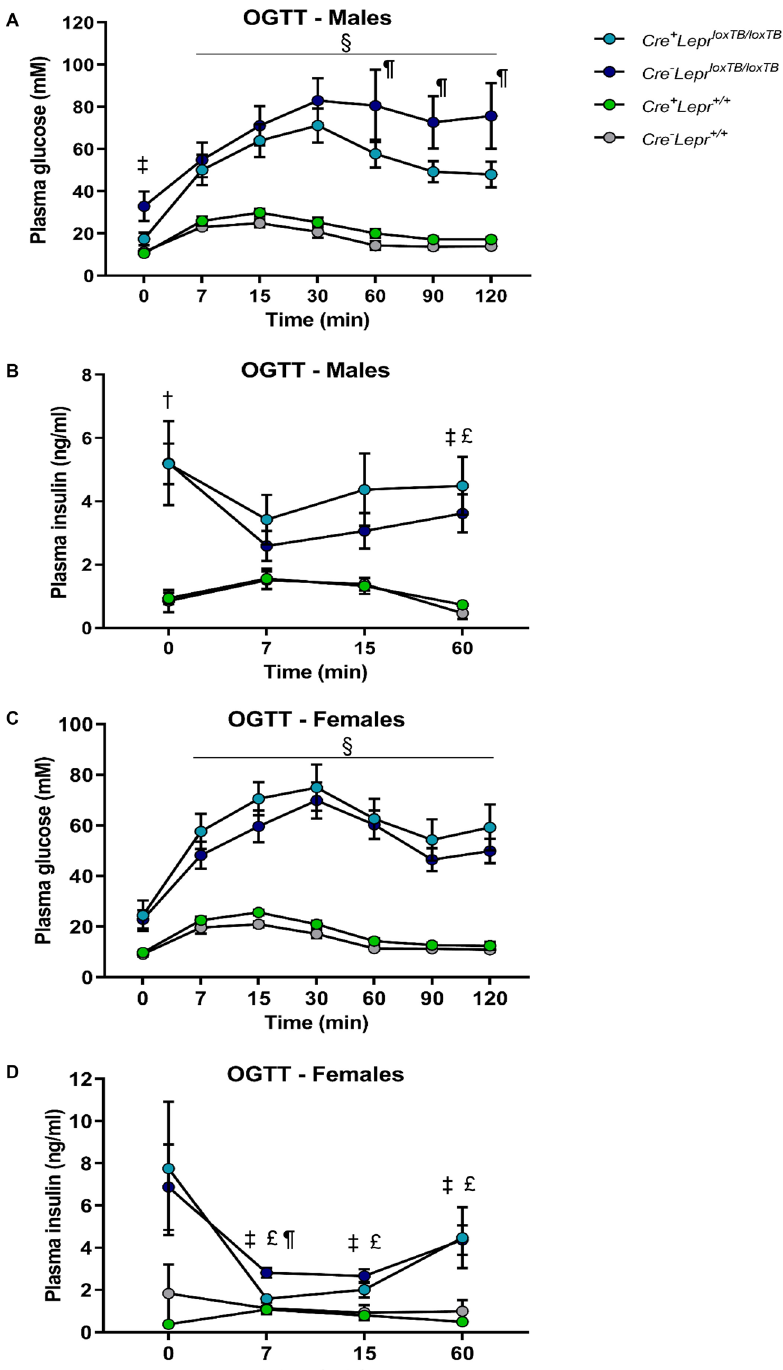
Figure 4. Plasma glucose ( A , C ) and plasma insulin ( B , D ) during oral glucose tolerance tests (OGTTs) in mice from the Lepr reconstitution study. In ( A ), n = 6 for Cre + Lepr loxTB/loxTB , n = 5 for Cre − Lepr loxTB/loxTB , n = 9 for Cre + Lepr + / + , and n = 6